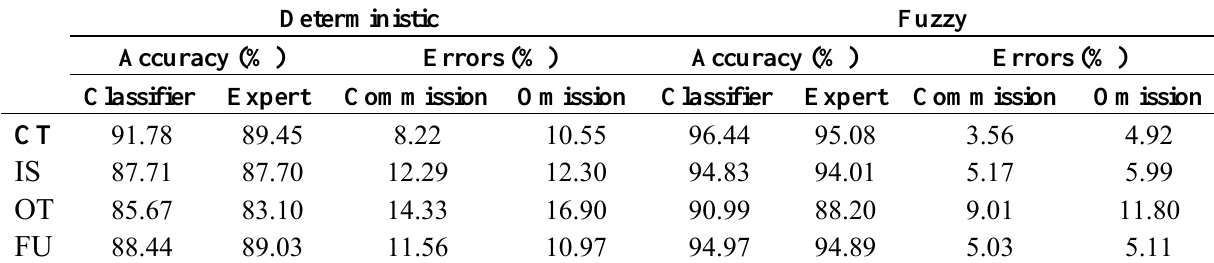
Table 5. Classifier and expert’s accuracy and errors for the combined (CT) and simple (IS, OT, FU) thresholding